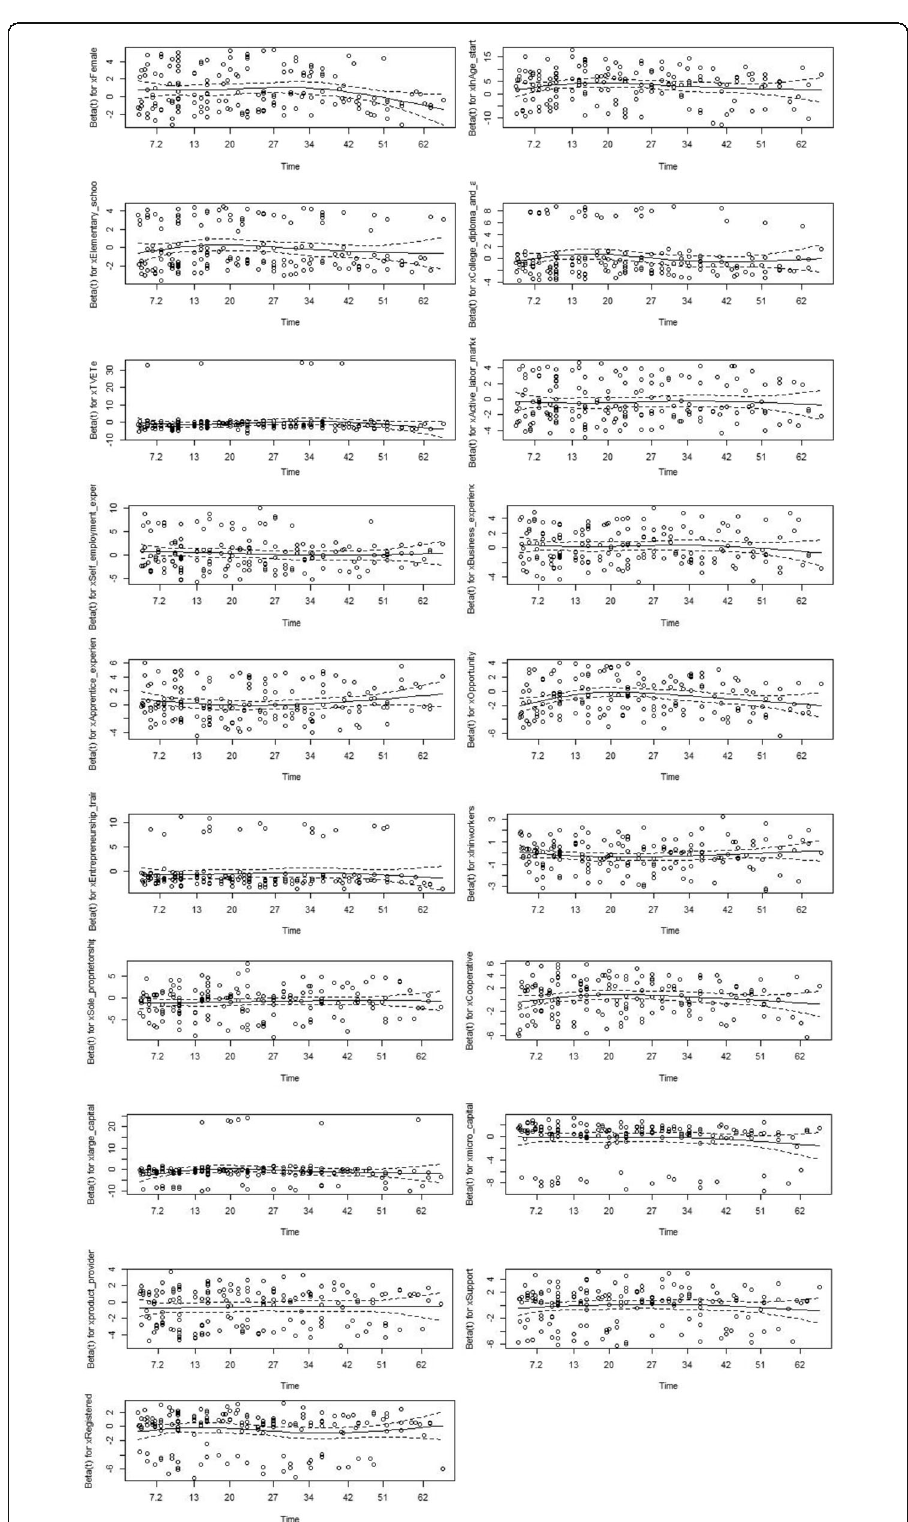
Fig. 3 Graphical diagnostic Schoenfeld residual test: model